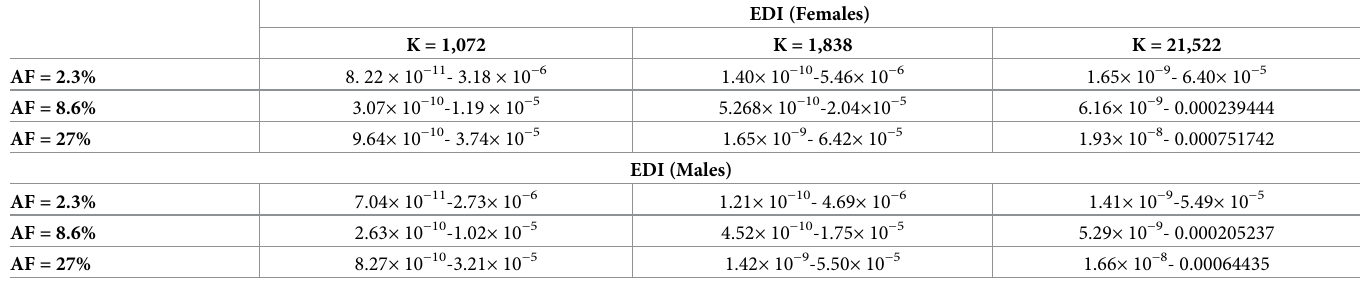
HF = 2; HT = 5 sec/time; BW = 60 or 70 Kg; C min = 0.02 μ g/g and C max = 776.2 μ